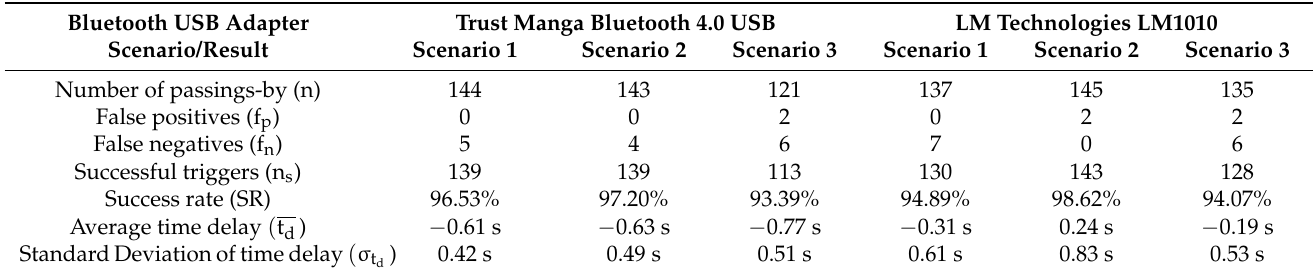
Table 10. Results of real-time localization for two external Bluetooth USB